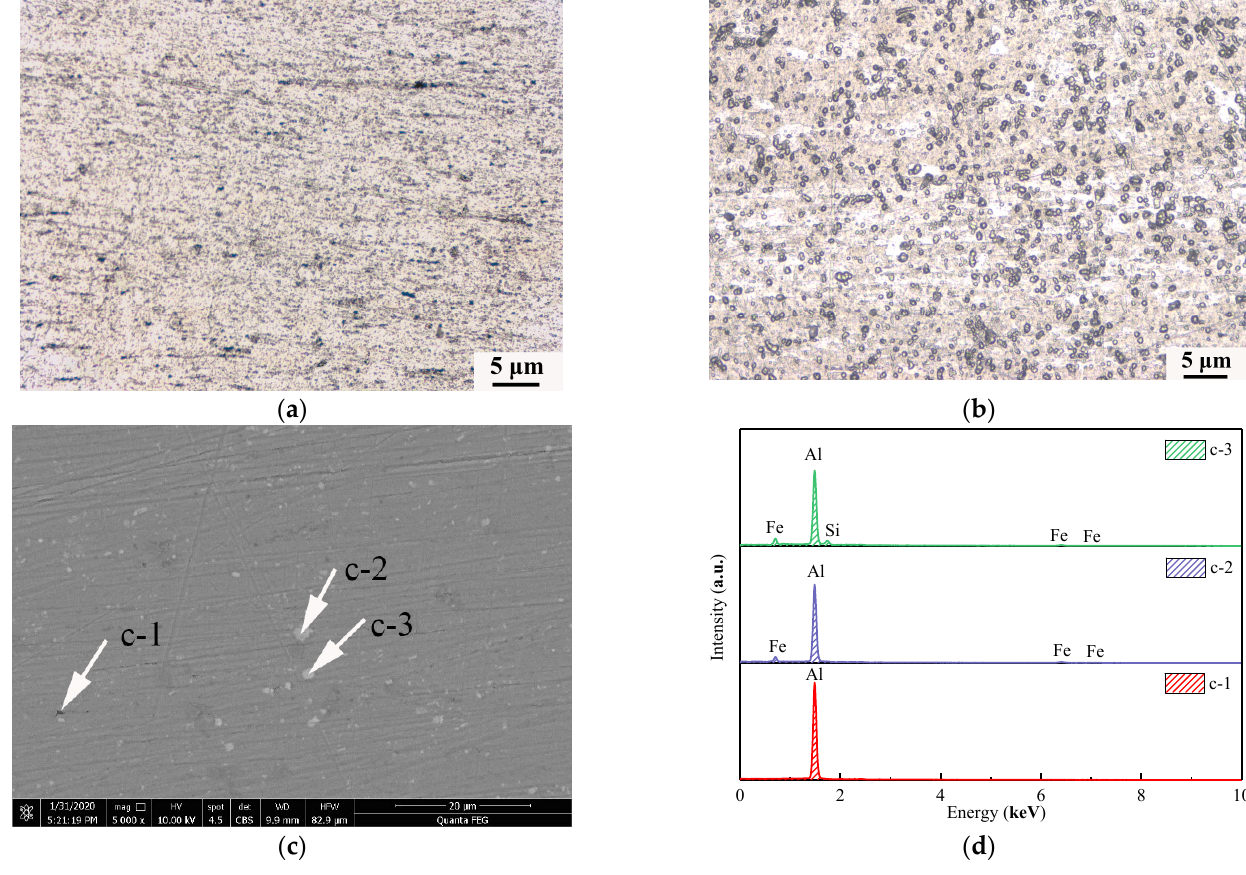
Figure 3. Macrostructural characteristics of wires at their rated currents: ( a ) metallographic structure of aluminum wires and; ( b ) aluminum alloy wires; ( c ); SEM image; ( d ) EDS analysis.